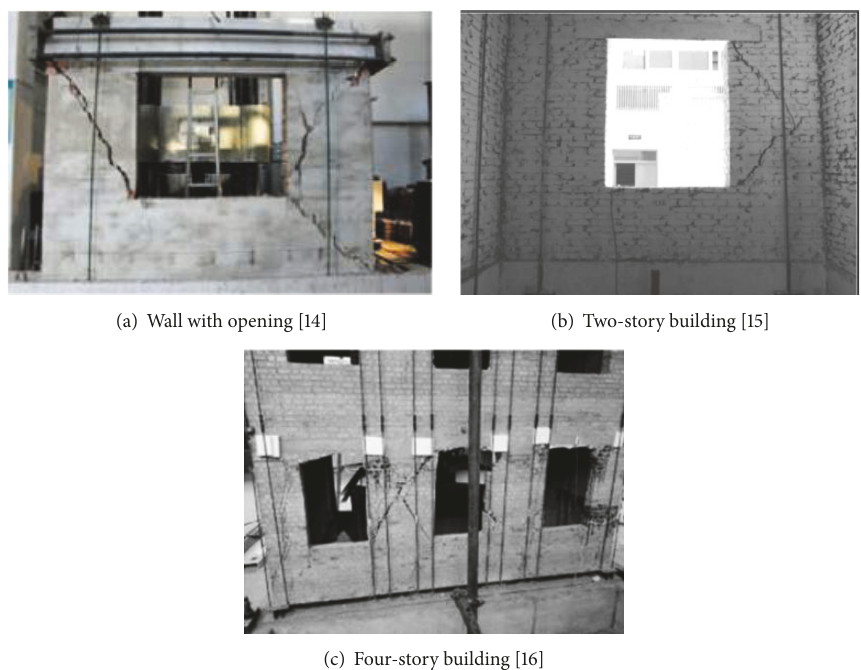
Figure 3: Photographs of masonry structures reinforced with external prestressed tendons in